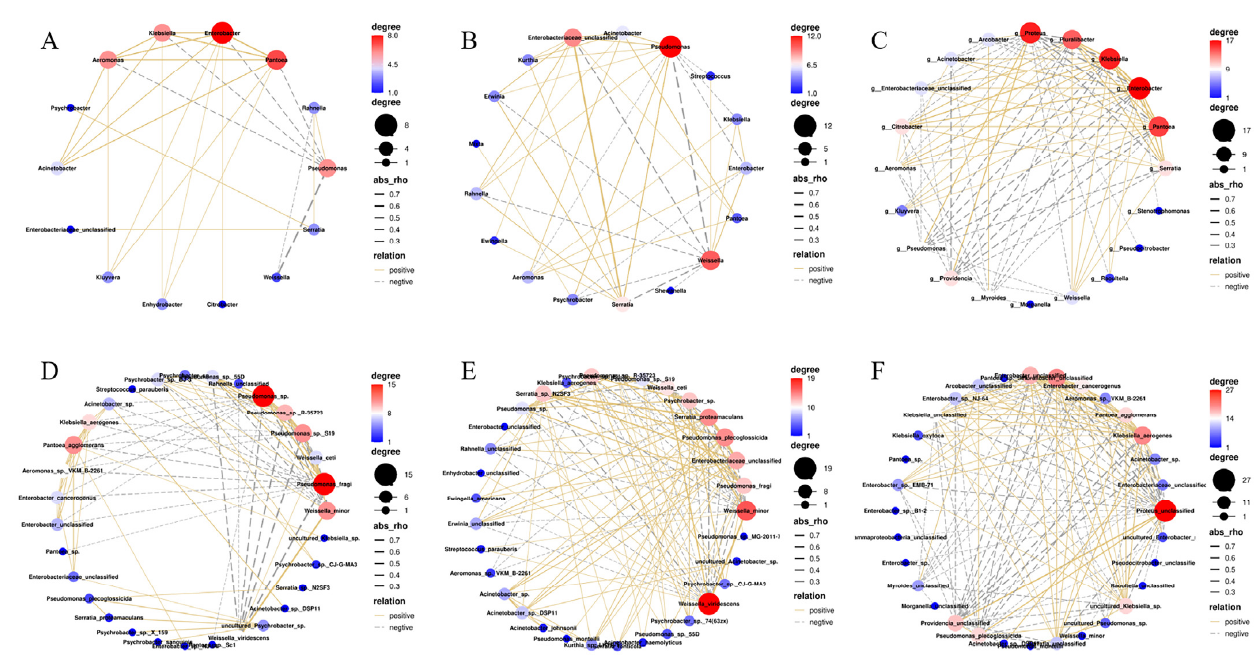
Figure 5. Microbial association networks calculated using SparCC, and the relative abundance da- ta for ( A – C ) genera and ( D – F ) species for storage temperatures of 4, 8 and 22 °C, respectively. At the species level, P. fragi , W. viridescens and P. unclassified were the main